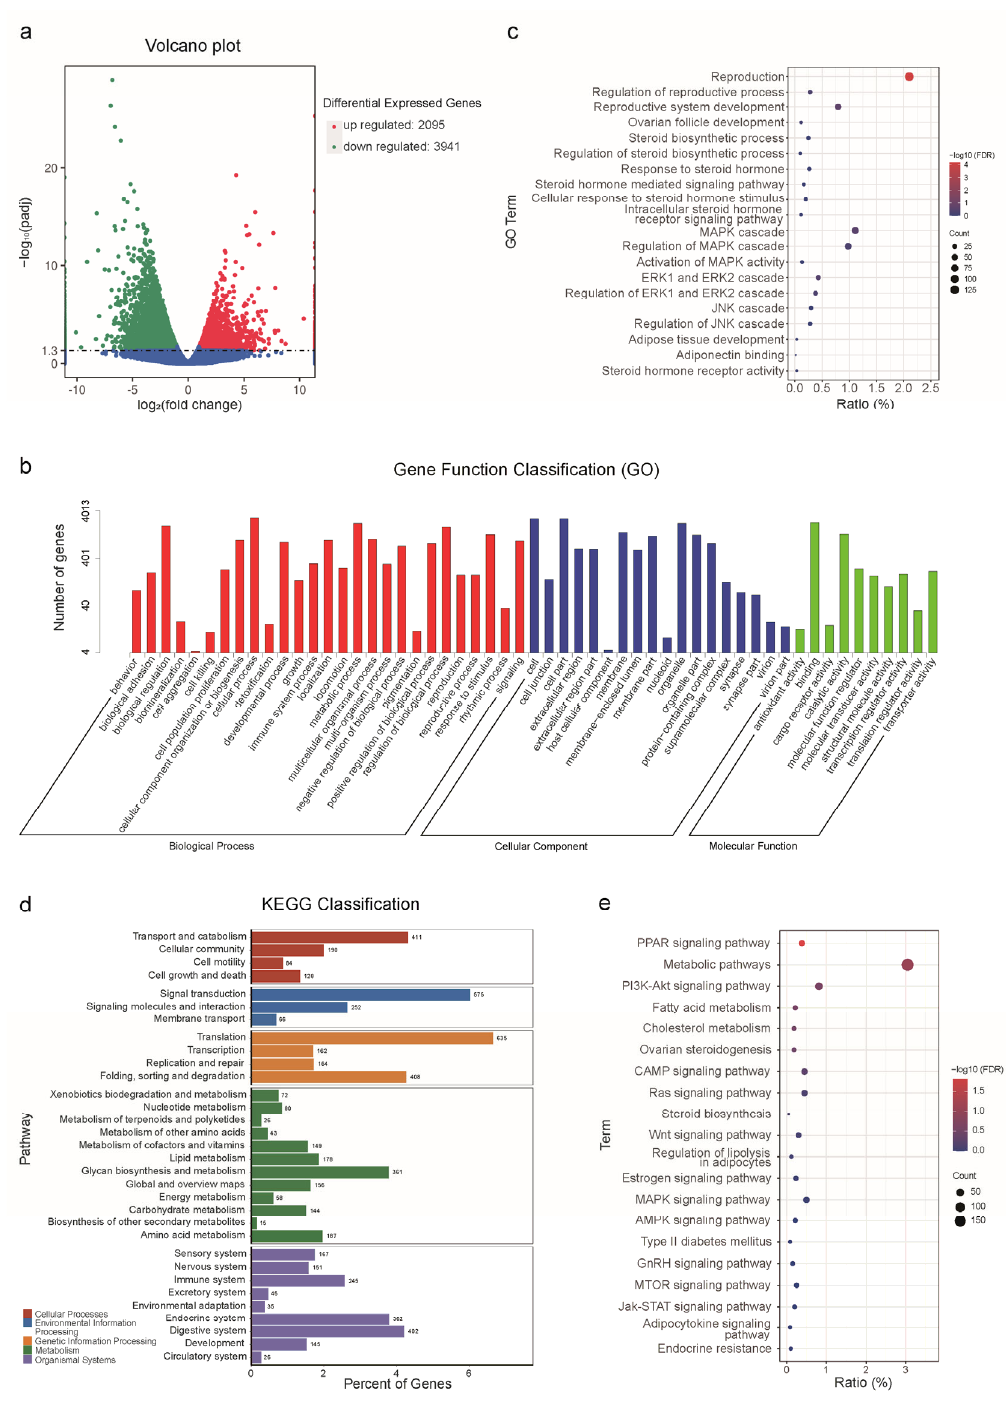
Figure 6. Volcano plot of genes expressed in the ovaries of wild ground squirrels during the breeding and non-breeding seasons ( a ). Functional annotation of DEGs in the ovaries of the two periods based on gene ontology (GO) categorization ( b ). GO significant enrichment bubble diagram of DEGs in the ovaries of the two periods ( c ). KEGG enrichment histogram of DEGs in the two periods ( d ). KEGG significant enrichment bubble diagram of DEGs in the ovaries of the two periods ( e